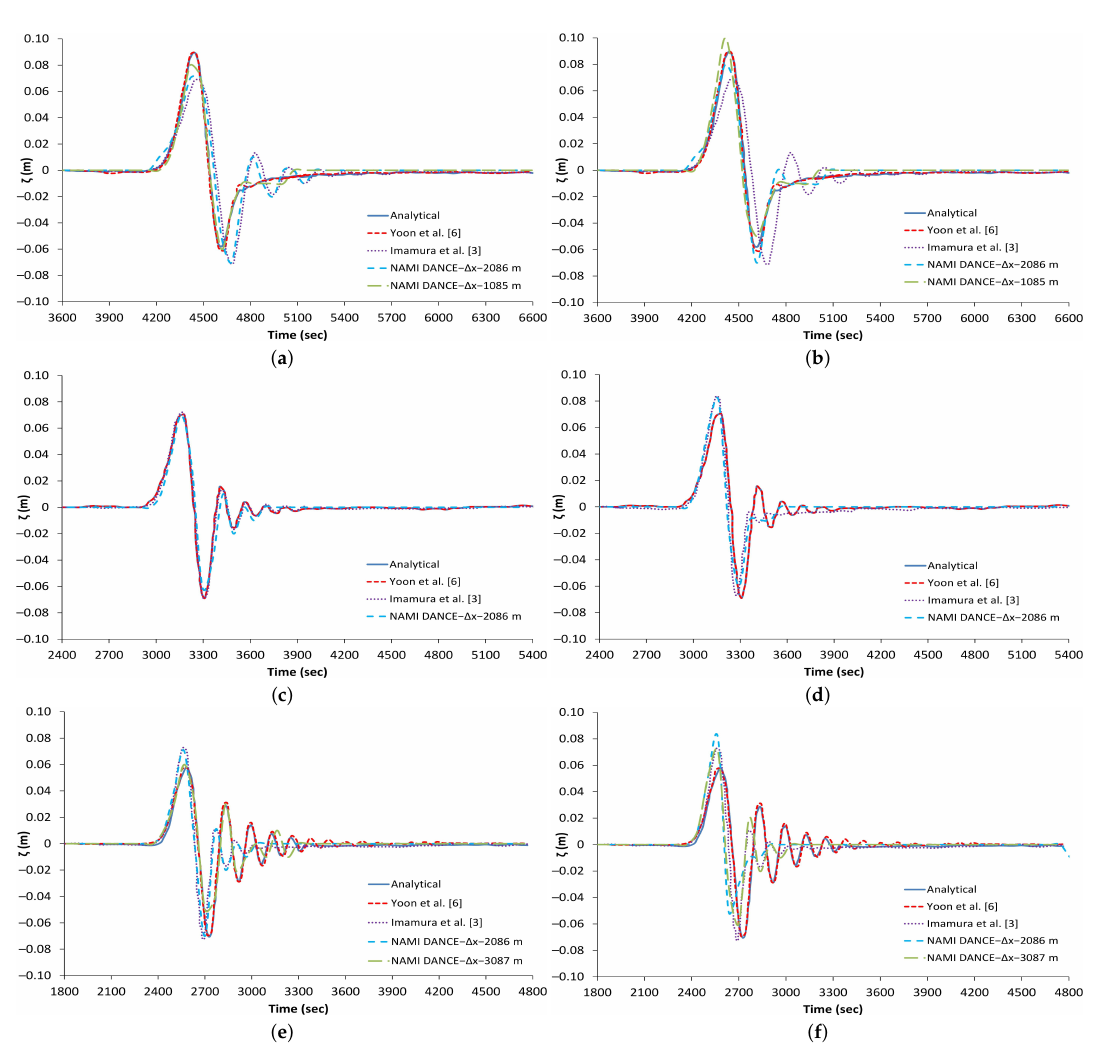
Figure 4. Comparison of water surface profiles of several numerical methods against the analytical solution of Carrier [27]: ( a ) h = 500 m and θ = 0 ◦ ,90 ◦ , ( b ) h = 500 m and θ = 45 ◦ , ( c ) h = 1000 m and θ = 0 ◦ ,90 ◦ , ( d ) h = 1000 m and θ = 45 ◦ , ( e ) h = 1500 m and θ = 0 ◦ ,90 ◦ , ( f ) h = 1500 m and θ = 45 ◦ . All comparisons are done at distance 312,900 m away from the center of the initial Gaussian hump on a uniform